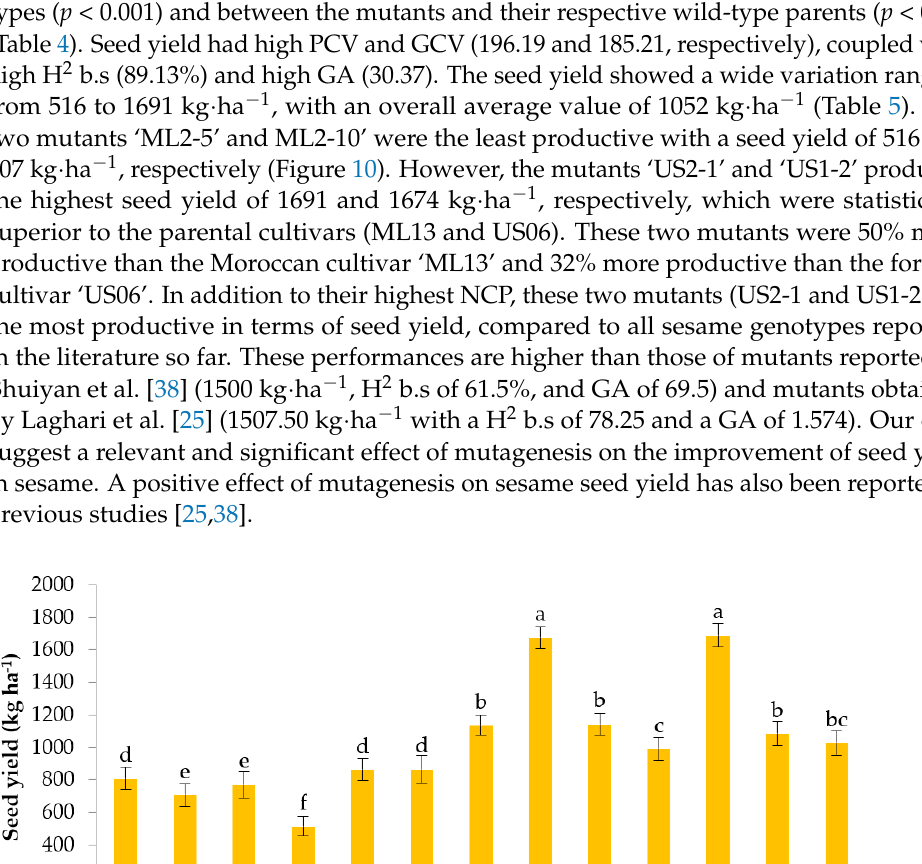
Table 6. Pearson’s correlation coefficients among the traits investigated.